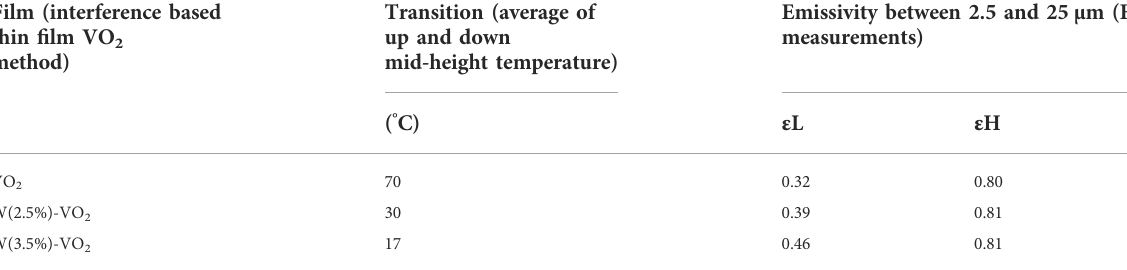
TABLE 1 Effect of W- dopant to VO 2 (Emittance = 1 − Re fl ectance) as a function of temperature.